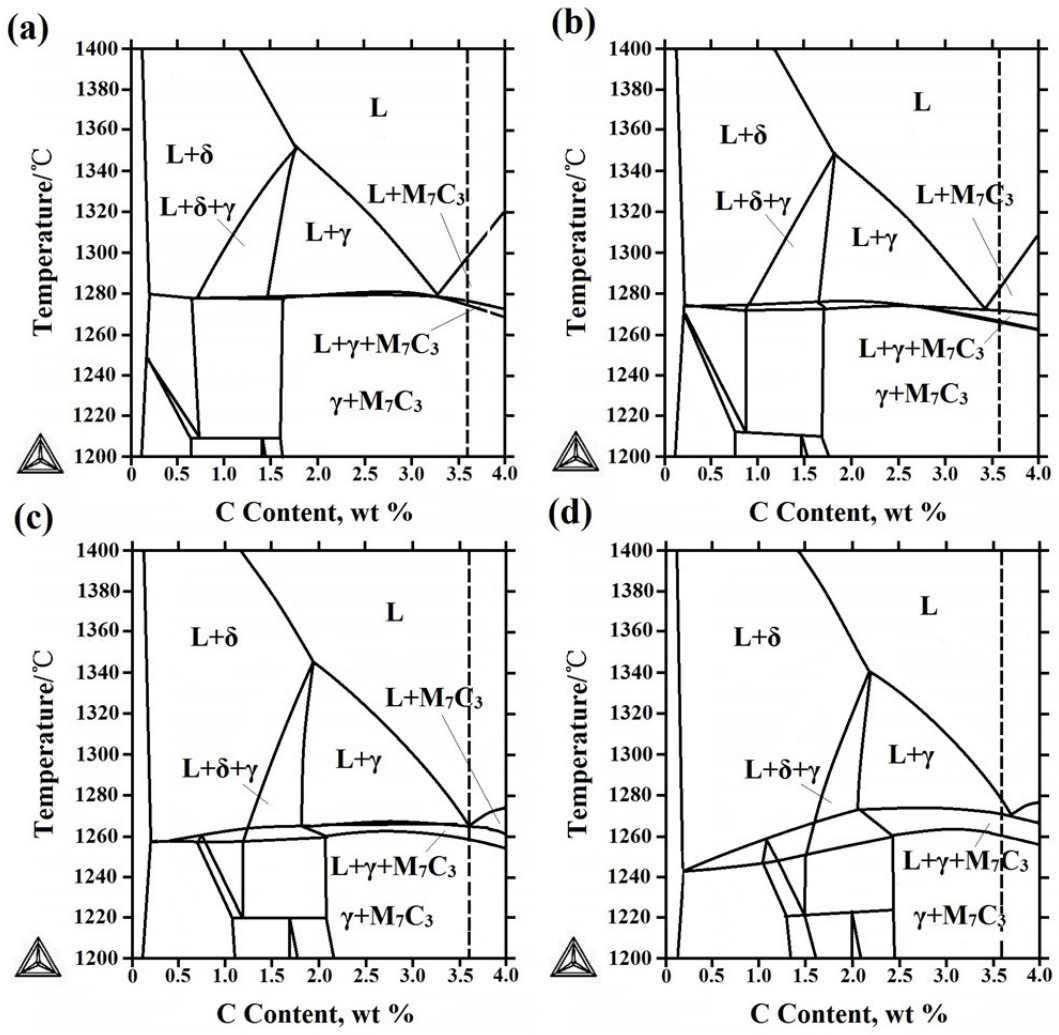
Figure 6. Phase diagrams of the hardfacing layers with ( a ) 3.6C-20Cr-Fe, ( b ) 3.6C-20Cr-Fe-0.83V, ( c ) 3.6C-20Cr-Fe-1.50V, ( d ) 3.6C-20Cr-Fe-2.32V.